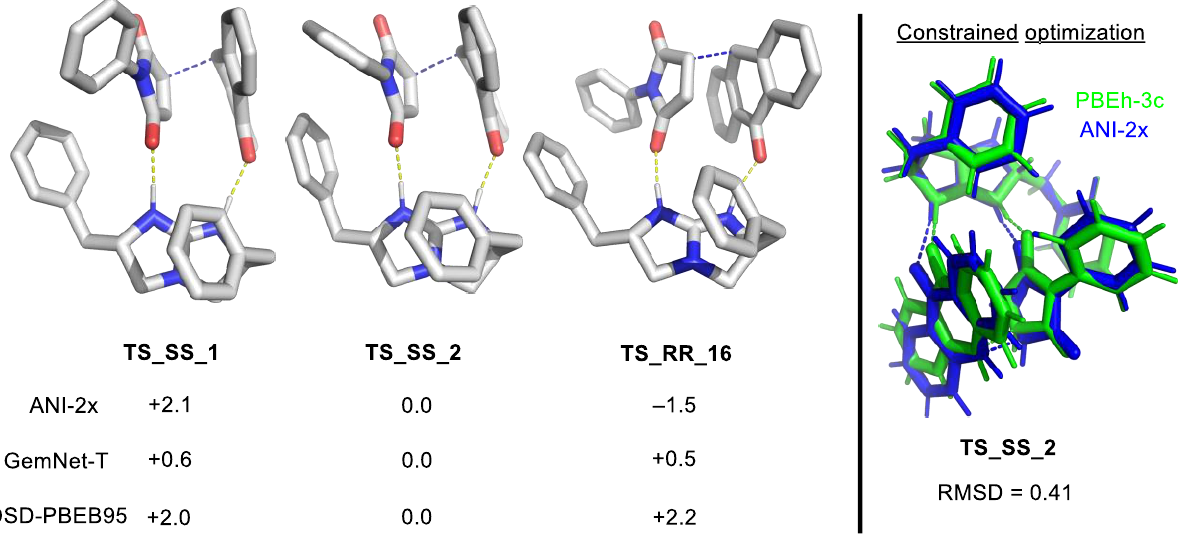
Figure 29. DSD-PBEB95: DSD-PBEB95-D3(BJ)/def2-QZVP. Values are taken from ref [32]. Geometries are generated from coordinates supplied by ref [32]. RMSD calculated by alignment function of PYMOL. Constrained optimization is done with ASE. In the constrained optimization, the two C atoms involved in the C-C bond formation are fixed (atom constraint).